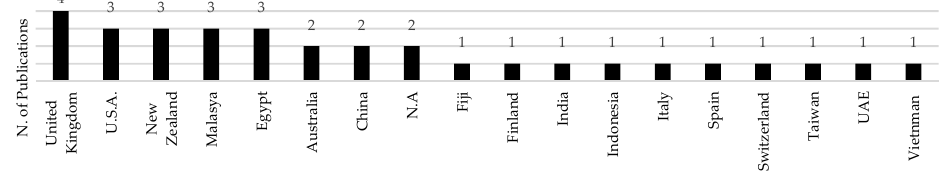
Figure 1. Number of publications by country.